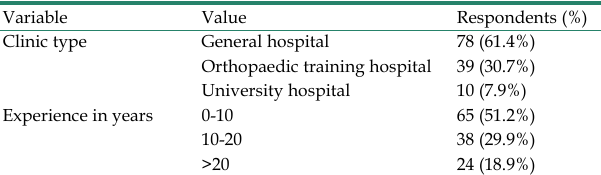
Table 1. Descriptives of respondents (n=127)